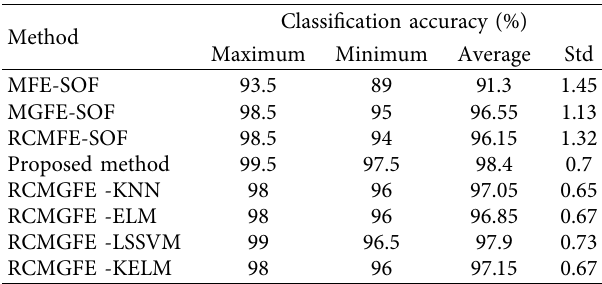
Figure 5: The classification results of various methods in the third experiment (a) result of MFE-SOF; (b) result of MGFE-SOF; (c) result of RCMFE-SOF; (d) result of proposed method; (e) result of RCMGFE-KNN; (f) result of RCMGFE-ELM; (g) result of RCMGFE-LSSVM; (h) result of Table 3: Classification results of different methods.